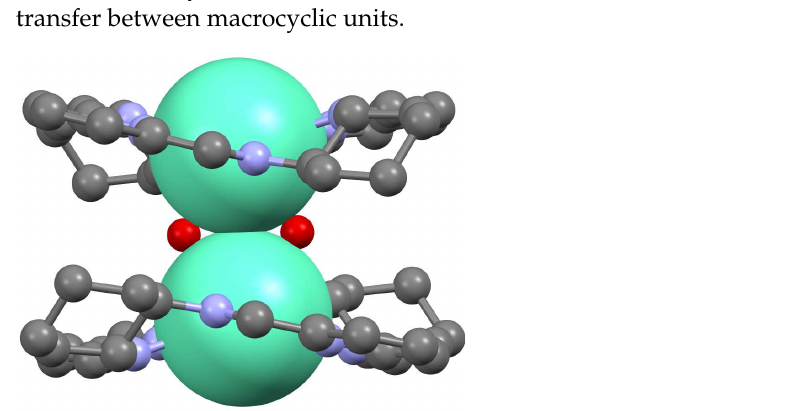
Figure 7. Side view of a dimeric complex where two Eu(III) ions residing in two macrocyclic units of 9 are linked by additional hydroxo bridges (metal ions are shown in spacefill representation, hydrogen atoms and additional anions are omitted for simplicity, Eu—green, N—blue, O—red). All the figures presenting molecular structures in this review were redrawn using the Mercury 2020.1 program and were based on the appropriate cif files deposited at the Cambridge Crystallographic Data Centre.